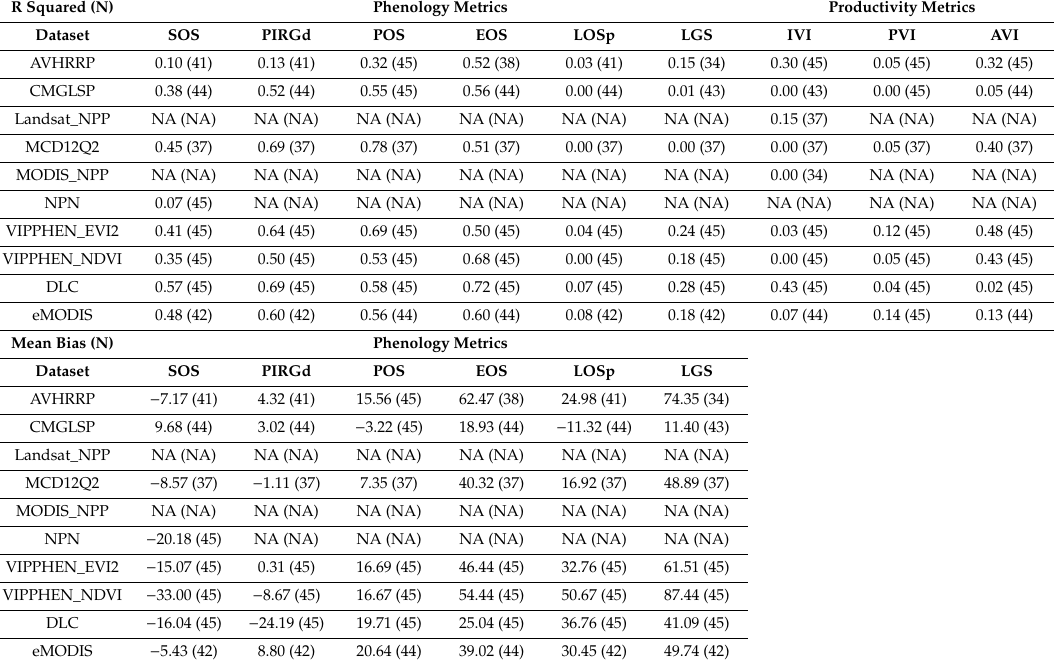
Table A3. Grasslands (GR) results.